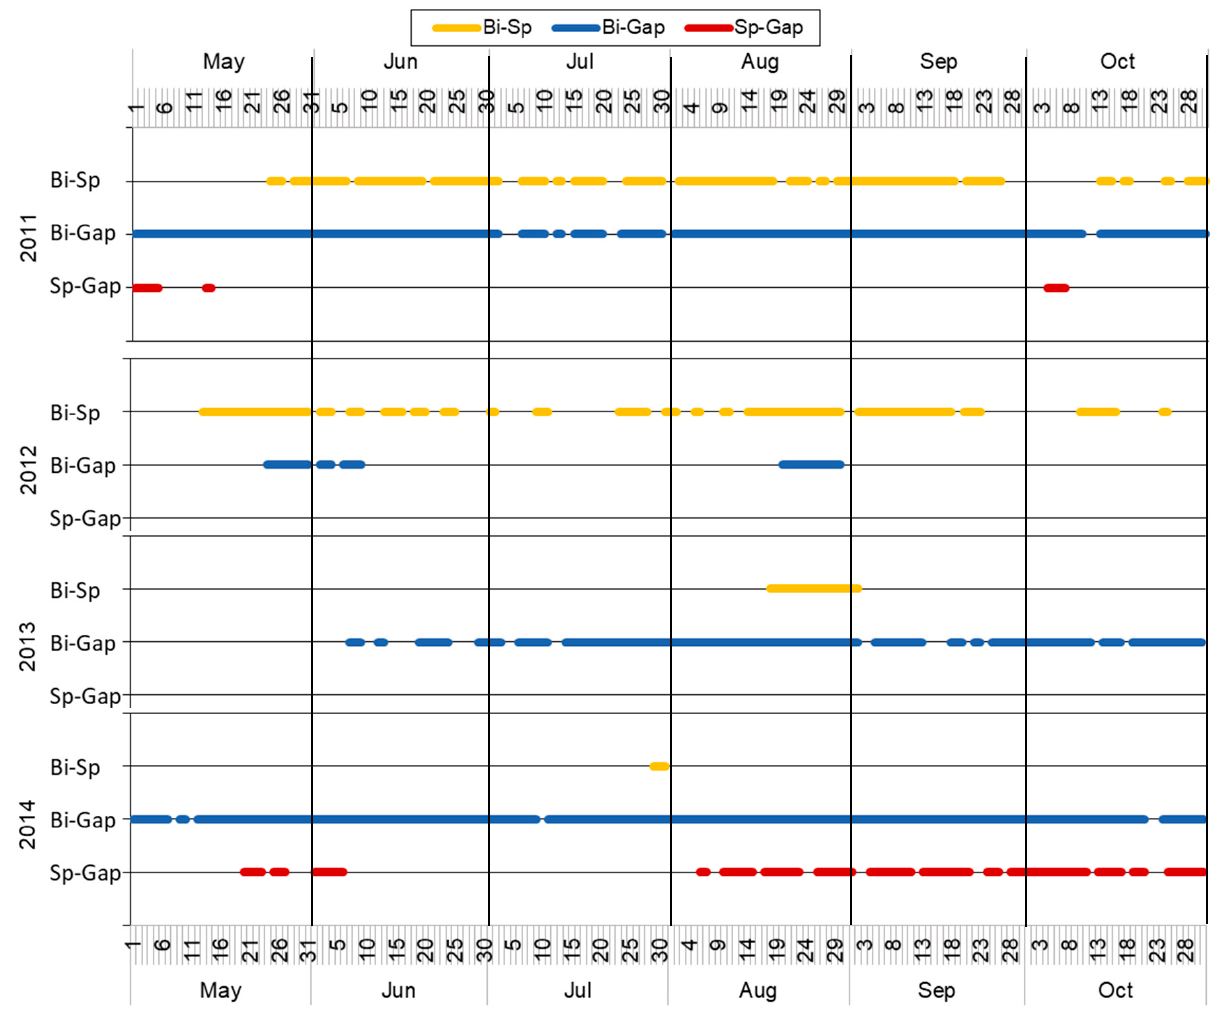
Figure 6. Periods with significant differences in topsoil moisture between treatments in 2011–2014. Bi-Sp—differences in birch and spruce treatment; Bi-Gap—differences in birch and gap treatments; Sp-Gap—differences in spruce and gap treatments.